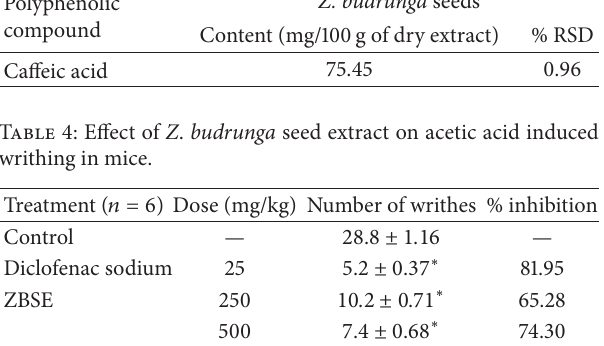
Figure 2: Standard calibration curve of gallic acid for determination of total phenolic content.